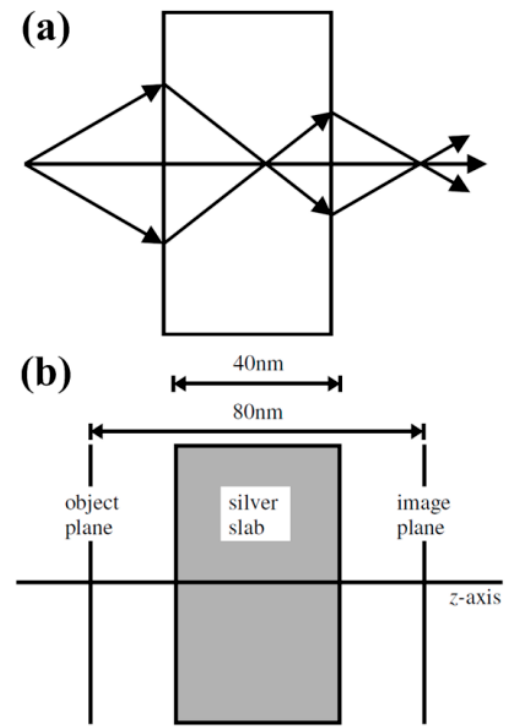
Figure 1. Pendry’s perfect lens. ( a ) Schematic drawing of a parallel-side slab with a negative refractive index acting as a perfect collecting lens. ( b ) A proposed silver slab lens with dimensions and object/image plane labeled. Reproduced with permission from [87]. Copyright American Physical Society, 2000.